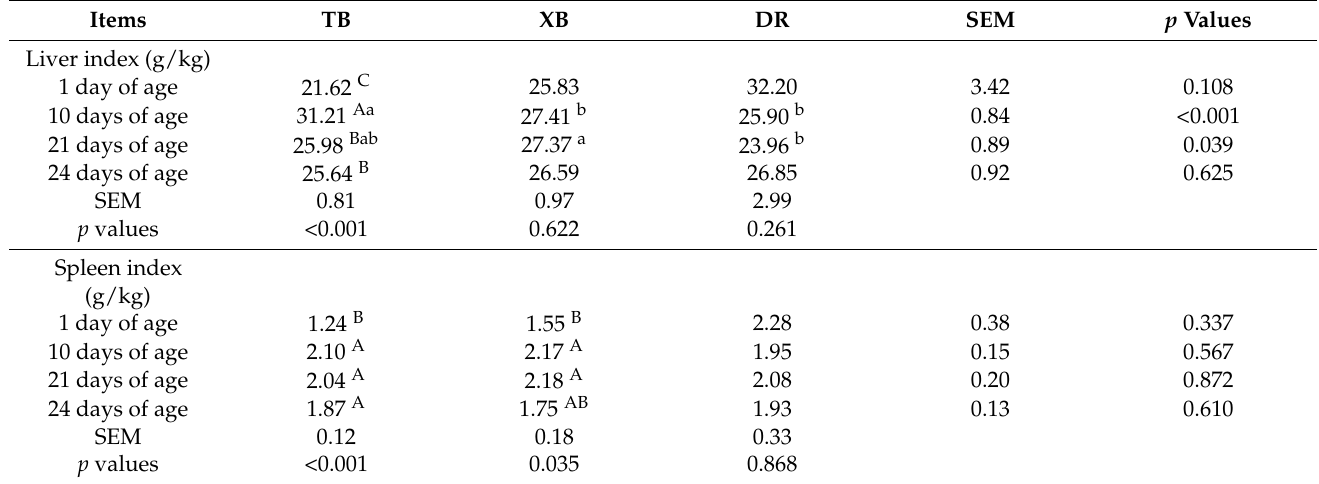
Table 1. Changes in organ indexes of different pig breeds during suckling and weaning